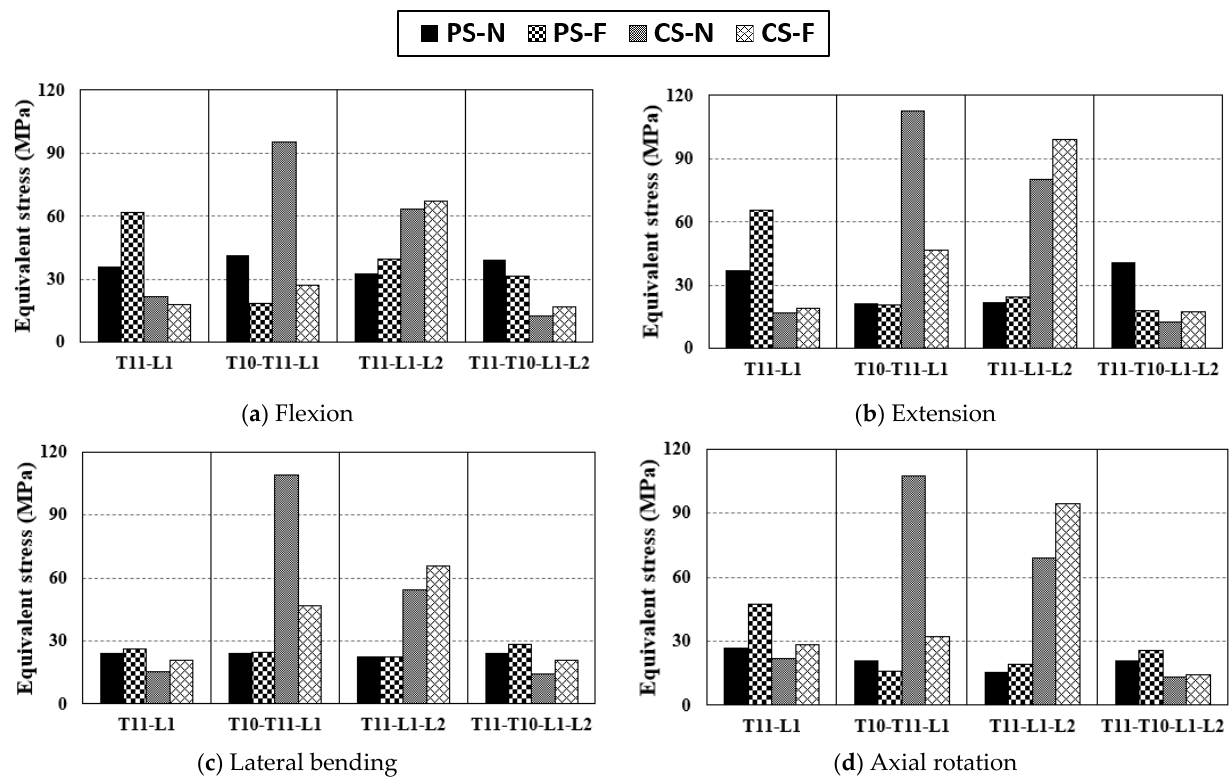
Figure 7. Equivalent stress applied to peri-implant bone by the pure moment: ( a ) equivalent stress of peri-implant bone in flexion, ( b ) equivalent stress of peri-implant bone in extension, ( c ) equivalent stress of peri-implant bone in lateral bending, and ( d ) equivalent stress of peri-implant bone in axial rotation.